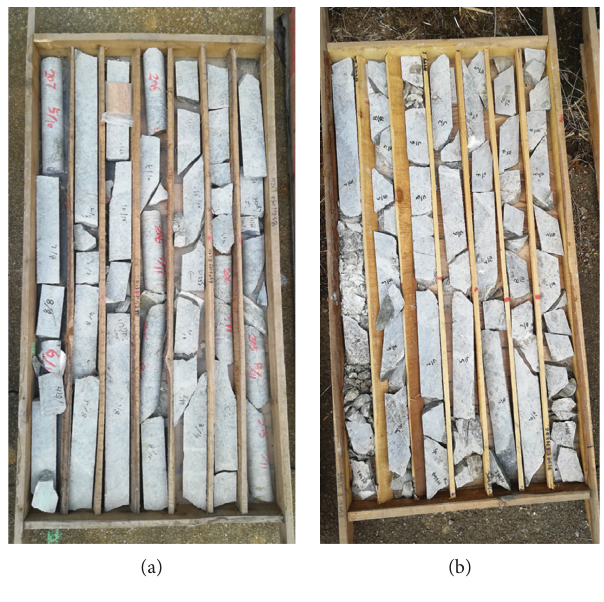
Figure 1: Half-cylinder cores.